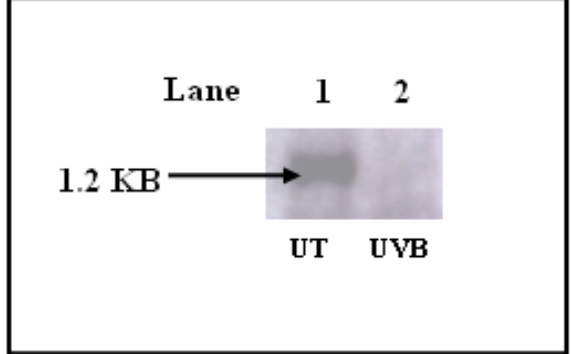
Figure 5: Down Regulation of Corneal Epithelial Cells after UVB Exposure. The differentially band, JS#6, was used as a probe; a 1.2 kb band was detected in the untreated (UT) cells (lane 1), whereas no band was detected in the UVB irradiated corneal epithelial cells (lane